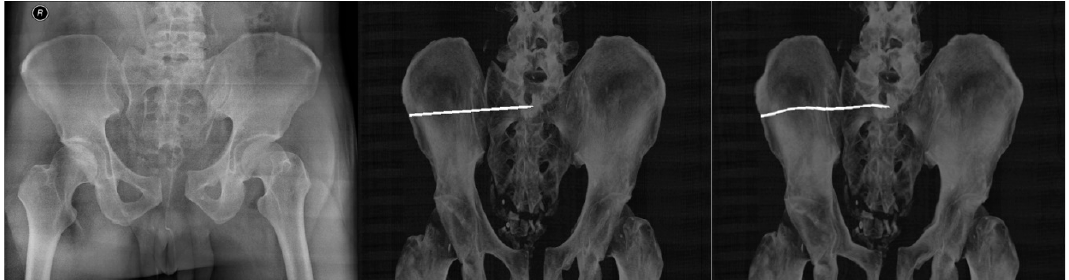
Figure 7. Result of Demons algorithm for multimodal image registration. ( Left , Middle , Right ): Target (reference) X-ray image, moving (input) DRR projection image, the output of image registration.